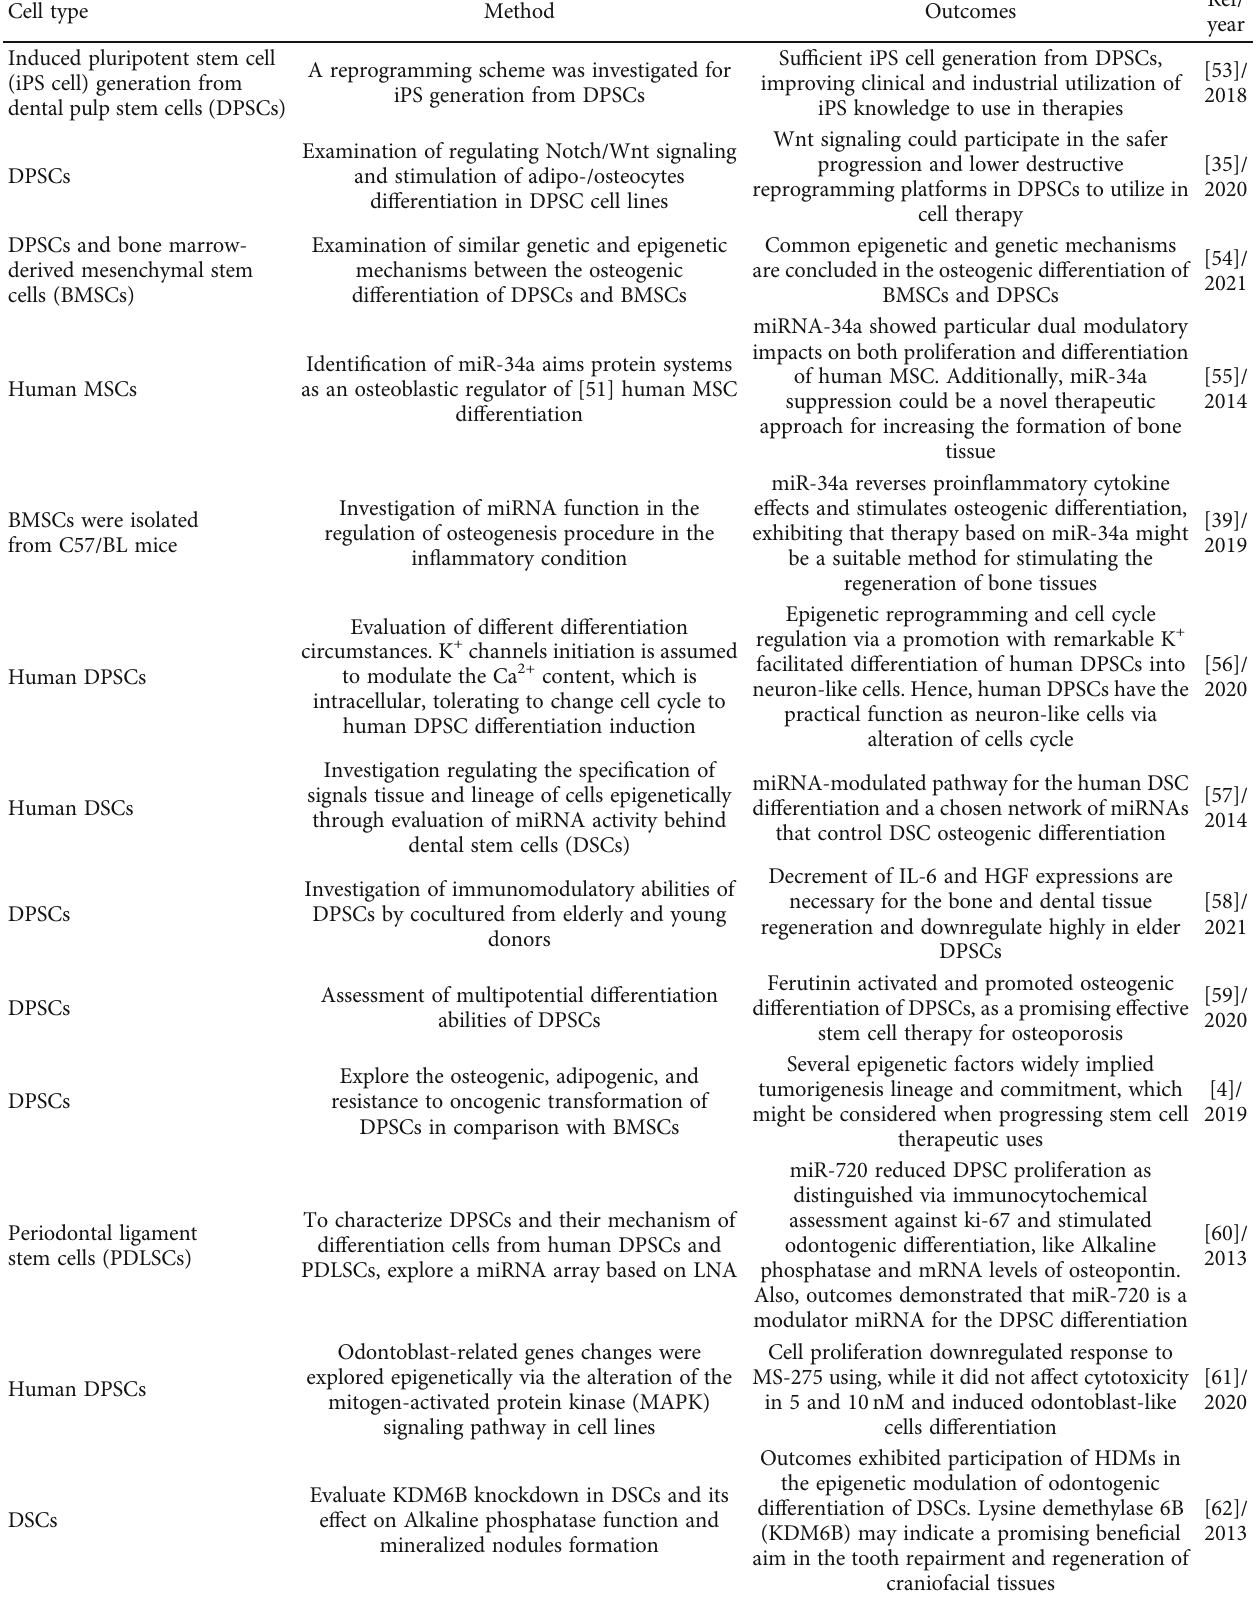
Table 1: The current studies of epigenetic regulation of dental stem cells in regenerative